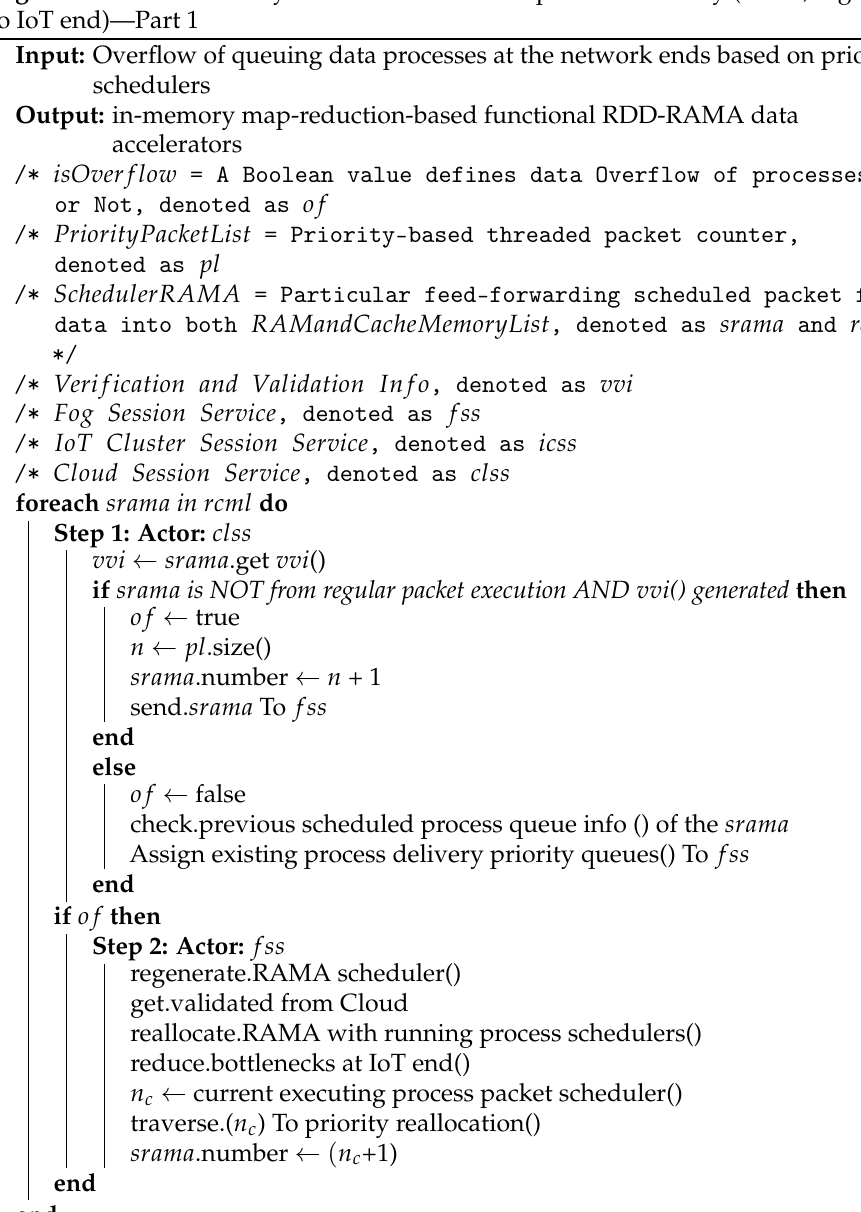
Algorithm 1: BDPS—delay efficient scheme for rapid data delivery (cloud,